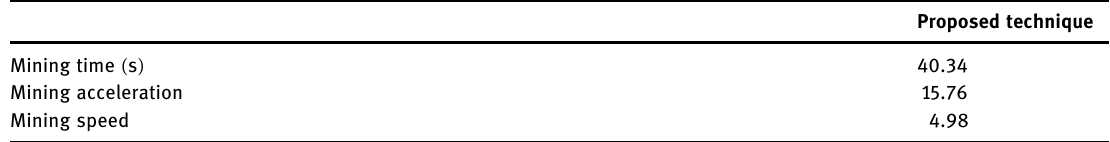
Proposed technique